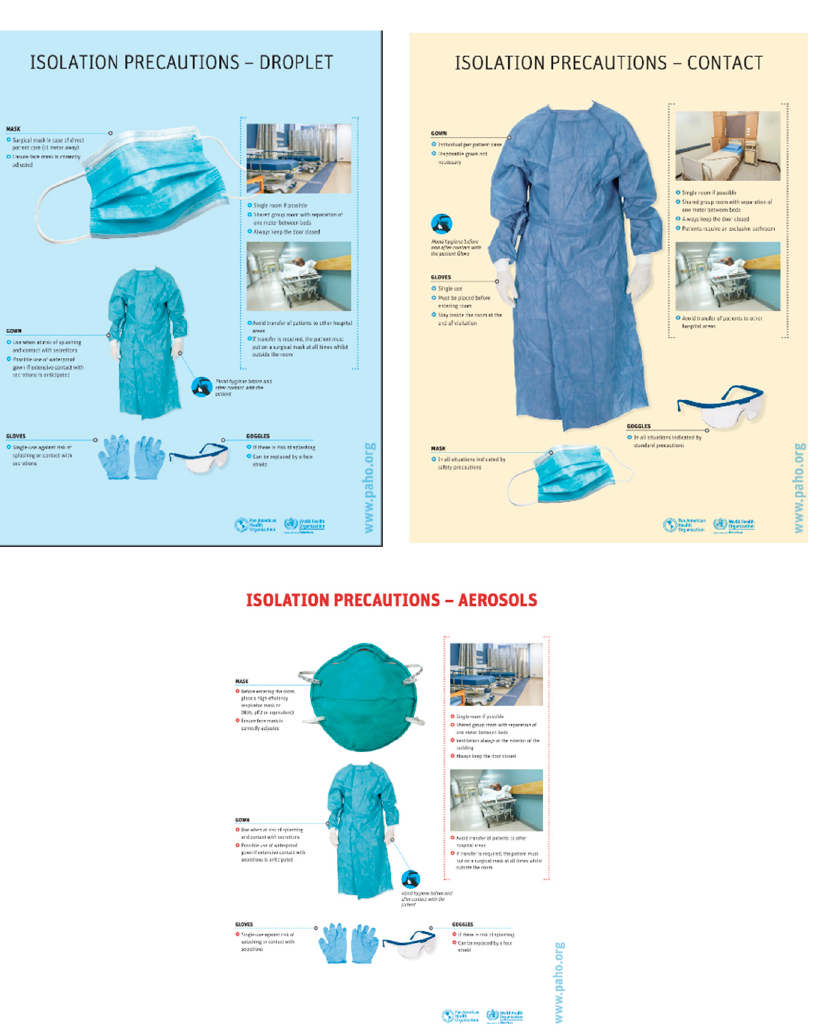
Figure 2. Communication materials provided to staff and medical settings to curb the spread of infection [18].